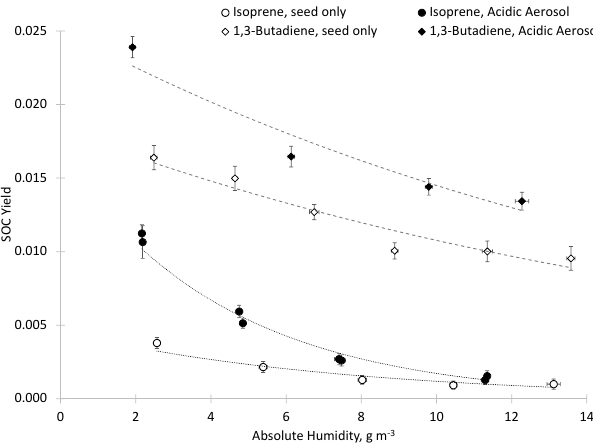
Figure 4. SOC yields for isoprene/NO and 1,3-butadiene/NO as a function of absolute humidity. In ER667 (isoprene, open cir- cles) and ER666 (1,3-butadiene, open diamonds), only a low- concentration ammonium sulfate seed aerosol was present. In ER662 (isoprene, closed circles) and ER444 (1,3-butadiene, closed diamonds), an acidic sulfate aerosol was